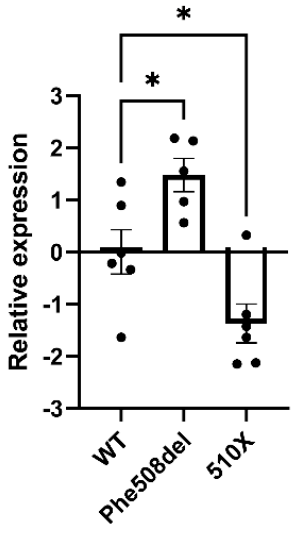
Figure 1. Cftr mRNA expression in ileum of 1 month old CF rats. Cftr expression in wild-type, Phe508del and 510X rat ileum was normalized to the average expression of the housekeeping genes β -actin and cyclophilin A. The relative expression of Cftr in the Phe508del and 510X ileum was compared to the wild type. Data are expressed as the mean ± SEM and analyzed by a one-way ANOVA with Dunnett’s multiple comparisons test to determine significance. * indicates p < 0.05, n = 6.